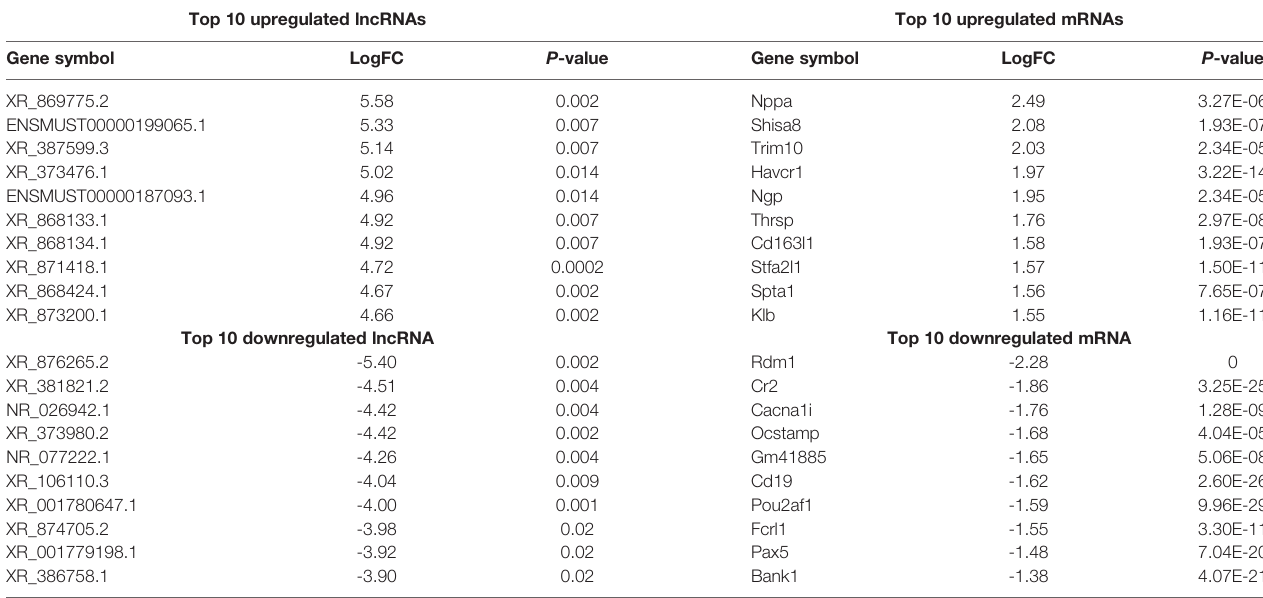
TABLE 2 | Top 10 differentially expressed lncRNAs and mRNAs between WT-PCP and BAFF-R – / – PCP mice. Top 10 upregulated lncRNAs Top 10 upregulated mRNAs